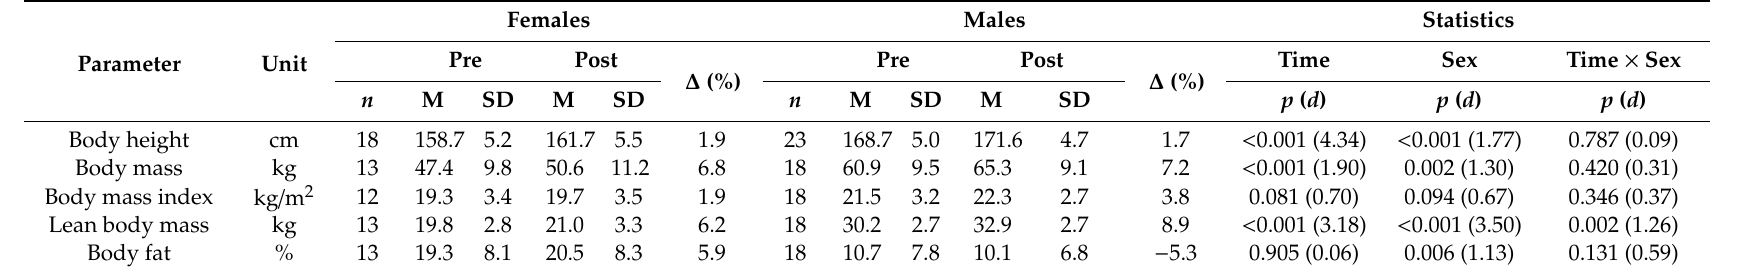
Table 1. Changes in anthropometry and body composition in young male and female judo